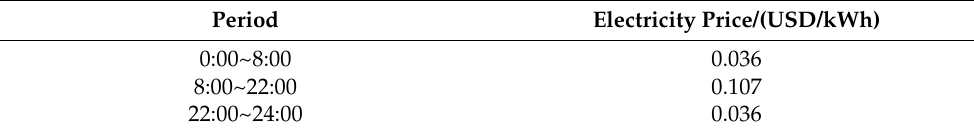
Table 5. Parameters of time-of-use tariff.